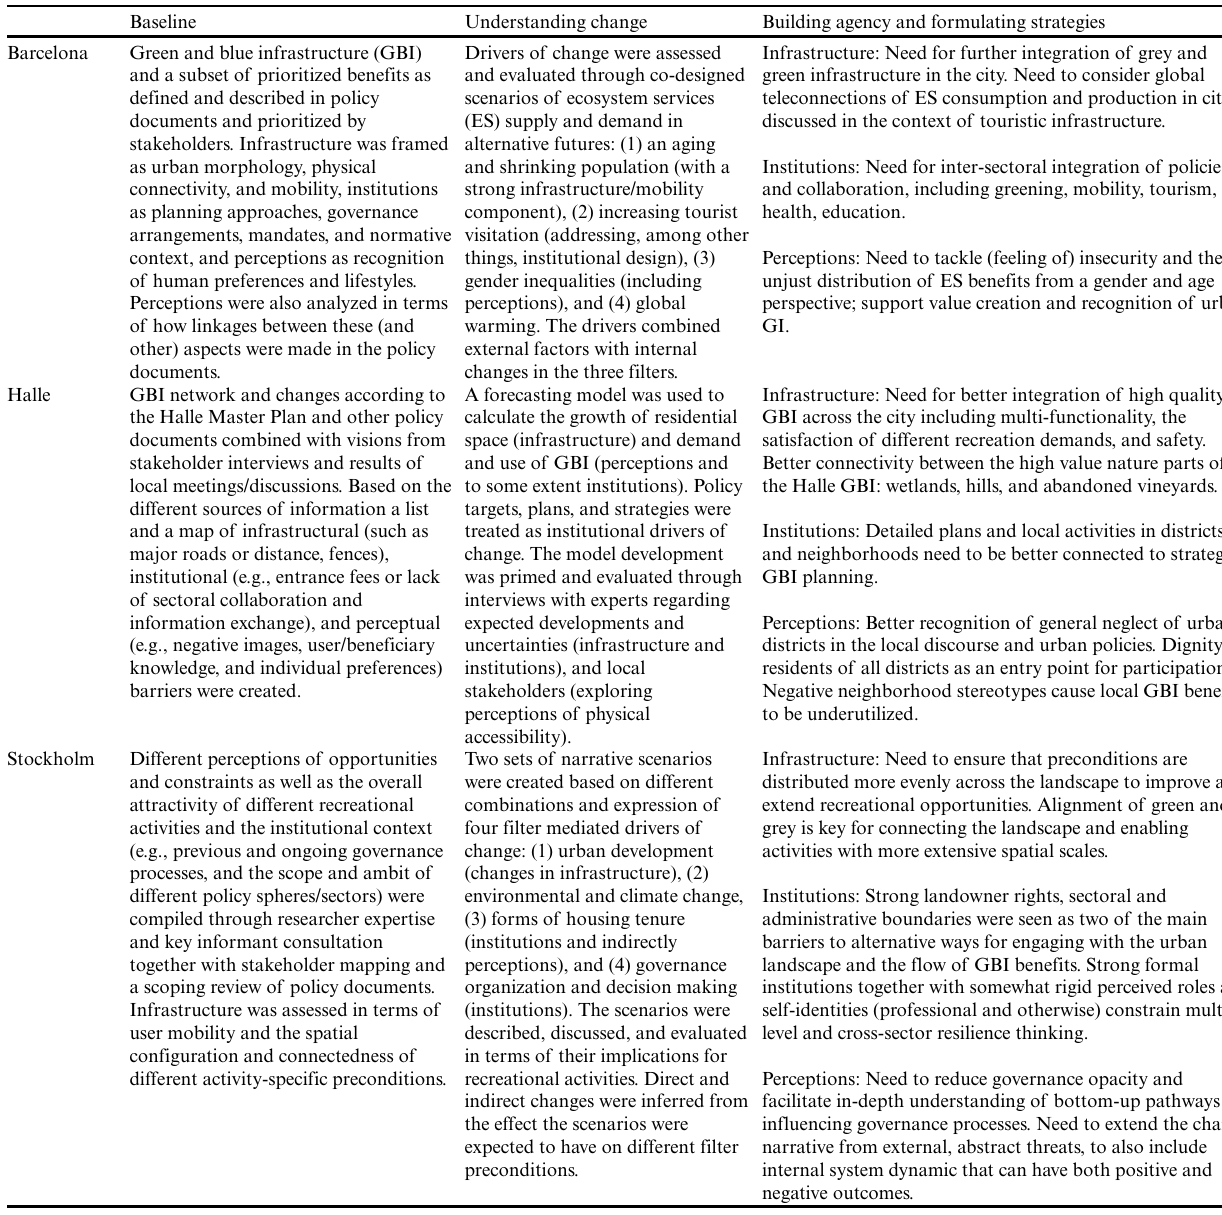
Table 2 . Overview, process, emphasis and outcomes of each case.